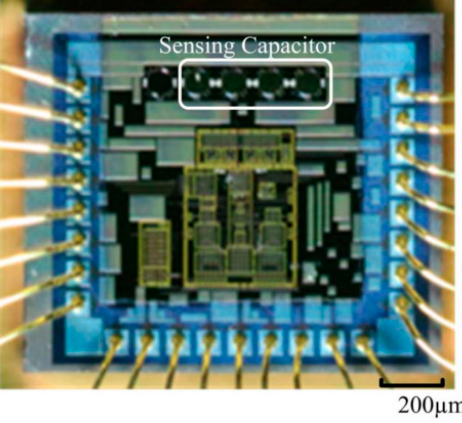
Figure 1. Micrograph showing sensing capacitor integrated on top a chip.